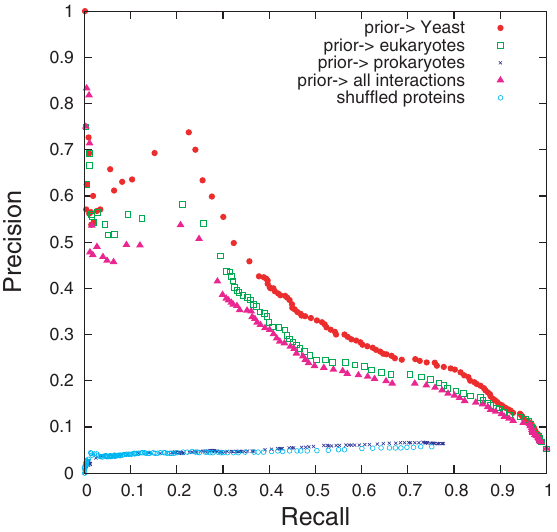
Figure 9. P-ROC Curves for Different Priors. The P-ROC curves for the different priors.